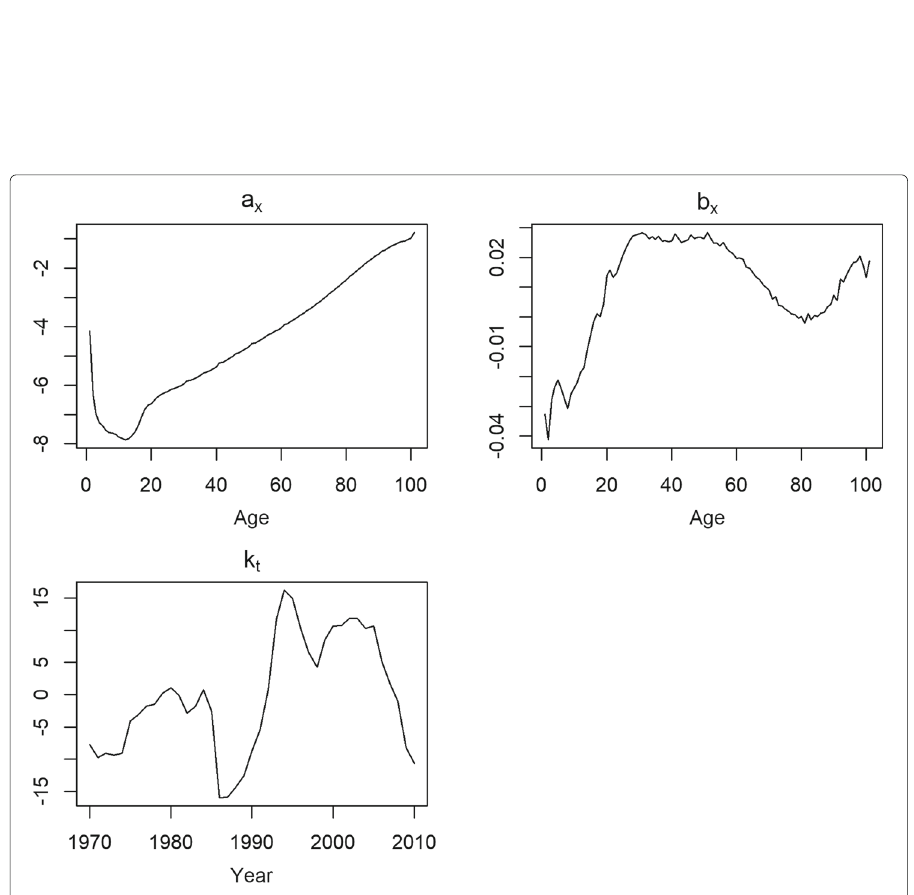
Fig. 10 Estimated parameters of first stage LC modeling on joint mortality data. Total 70% variation was explained by the fitted